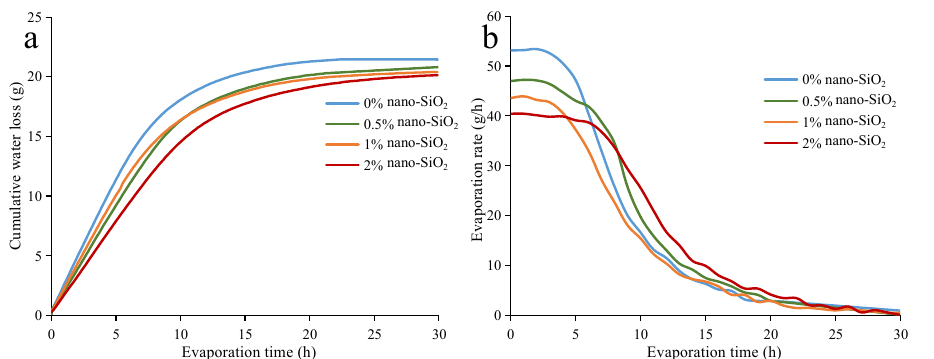
Figure 4. The ( a ) cumulative water evaporation loss and ( b ) evaporation rate of nano-SiO 2 -reinforced clayey soil.